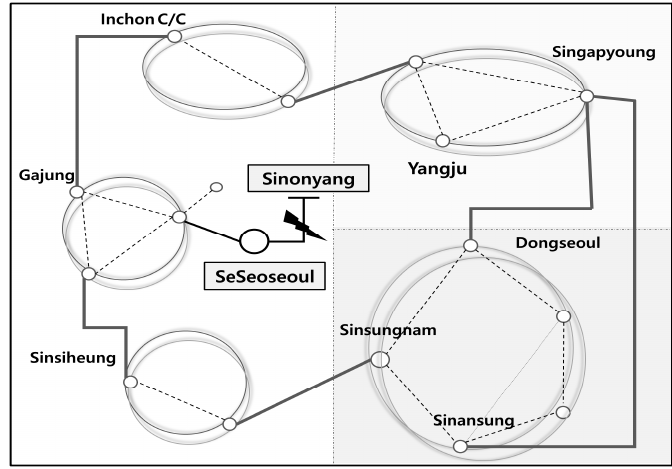
Figure 2. AC grid structure in the Korea metropolitan area.